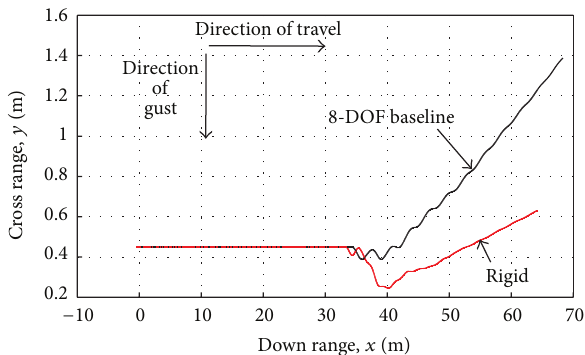
Figure 10: Rigid and articulated MAV trajectory in response to a 2m/s crosswind gust.